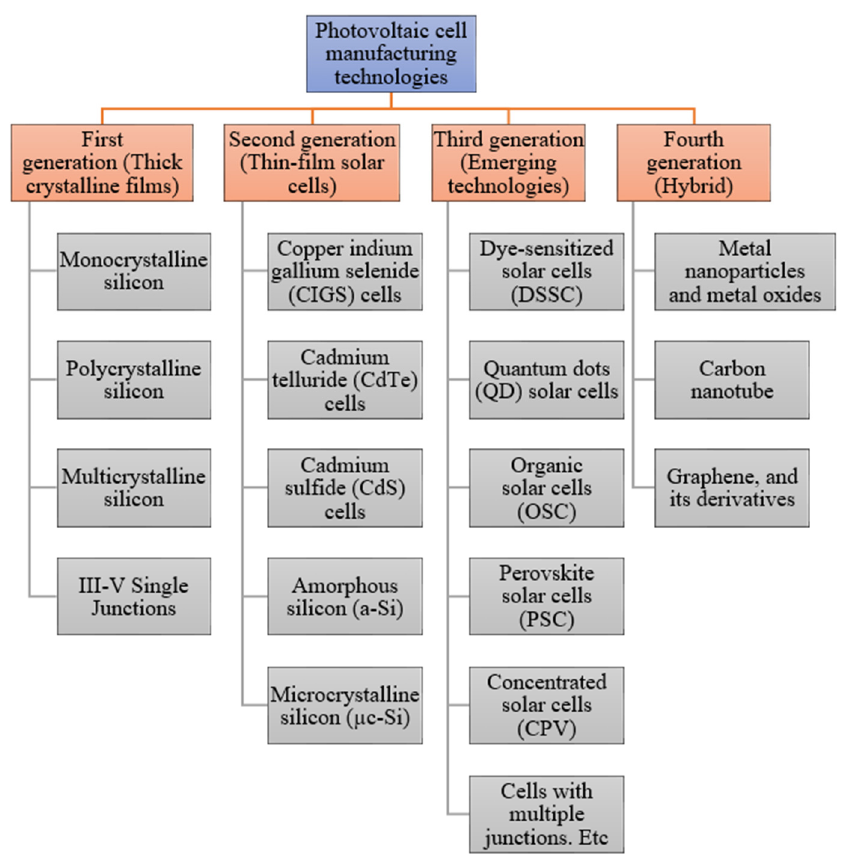
Figure 2. Various solar cell types and current developments within this field [14].